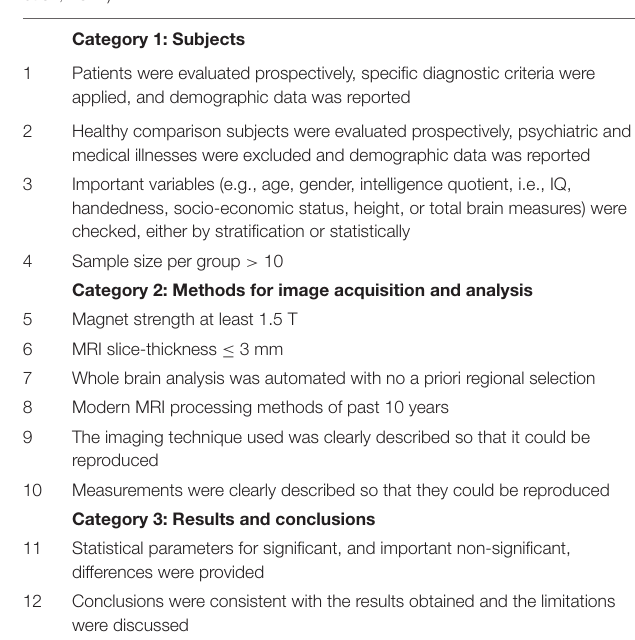
TABLE 1 | Customized checklist for study quality assessment (adopted from Du et al.,